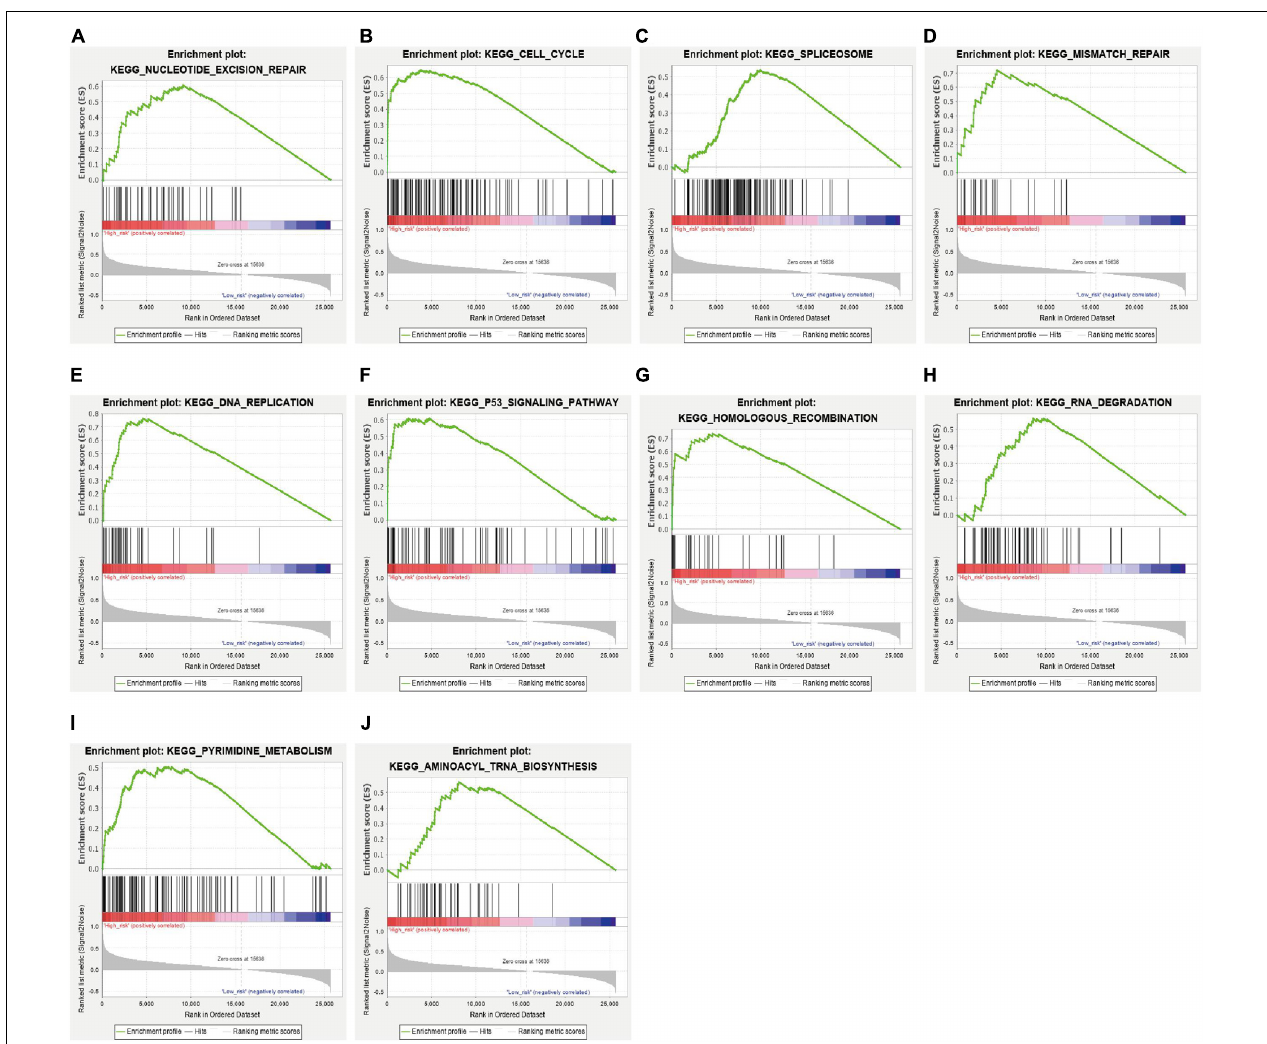
FIGURE 7 | GSEA between PAAD patients with high risk score and those with low risk score (A–J)